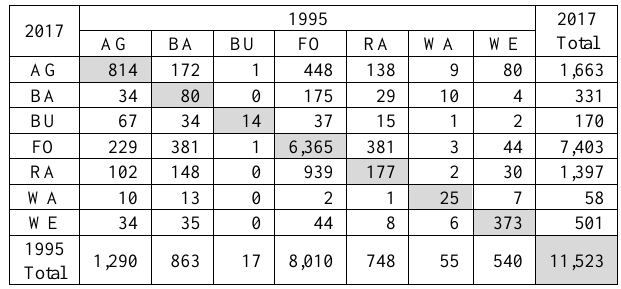
Table 6. Matrix of land cover and changes from 1995 to 2017 in the portions of ARB upstream of Dankias Station (in km 2 ). (Legend: AG – agriculture; BA – barren land, BU – built-up land, FO – forest, RA – rangeland, WA – water, WE –